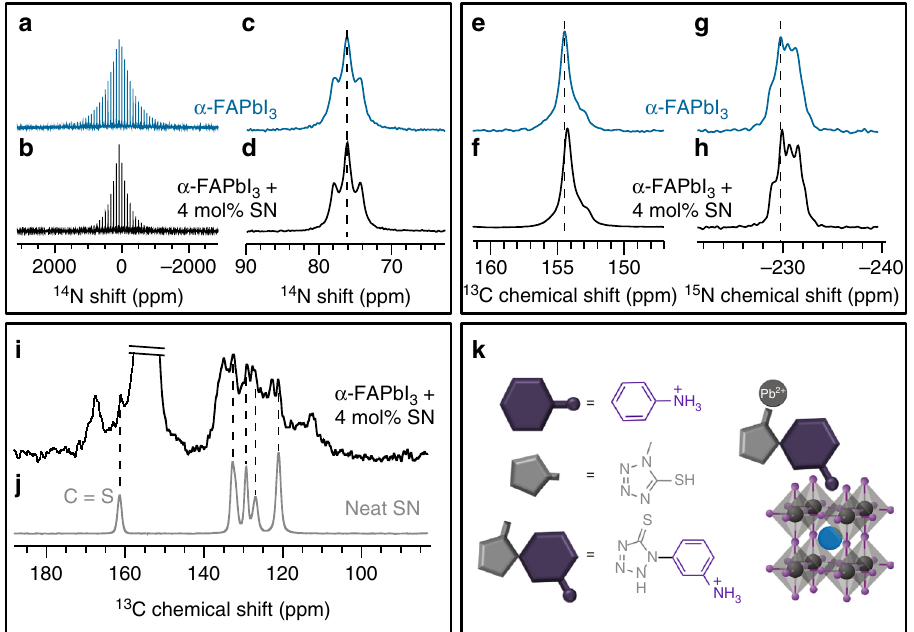
Fig. 3 Investigation of the origin of perovskite modulation by NMR spectroscopy. a – d 14 N solid-state MAS NMR spectra at 11.7 T, 298 K and a , b 3 kHz, c , d , 20 kHz MAS of bulk mechanochemical a , α -FAPbI 3 and b , α -FAPbI 3 doped with 4 mol% SN. c , d , shows the corresponding close-up views of the center band. The triplet is caused by the 1 H- 14 N J-coupling. e – j , 13 C CP and 15 N CP solid-state MAS NMR spectra at 11.7 T, 105 K and 10 kHz MAS of bulk mechanochemical e , g α -FAPbI 3 and f , h α -FAPbI 3 doped with 4 mol% SN (intensity normalized to the peak of α -FAPbI 3 ). i , j 13 C CP solid-state MAS NMR spectra at 11.7 T, 105 K, and 10 kHz MAS of i , bulk mechanochemical α -FAPbI 3 doped with 4 mol% SN (scaled 64 times to highlight the SN resonances) and j neat SN powder. k Schematic representation of the structure of molecular modulators N (purple), S (gray), and SN (purple-gray), and the interaction of the bifunctional molecular modulator SN with Pb 2 + ions (gray sphere) and perovskite crystal structure (general formula FAPbI 3 , where FA is represented by the central blue sphere, while Pb 2 + and I – are shown as gray and bright purple spheres, respectively). MAS: magic angle spinning, CP: